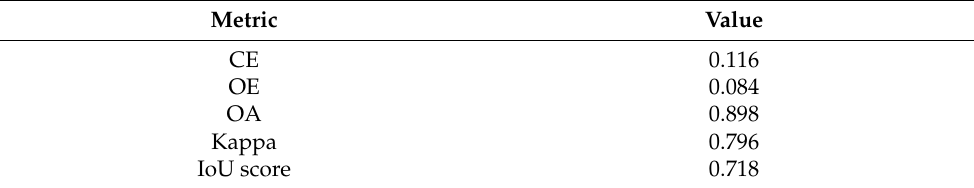
Table 2. Accuracy metrics for field boundary delineation.